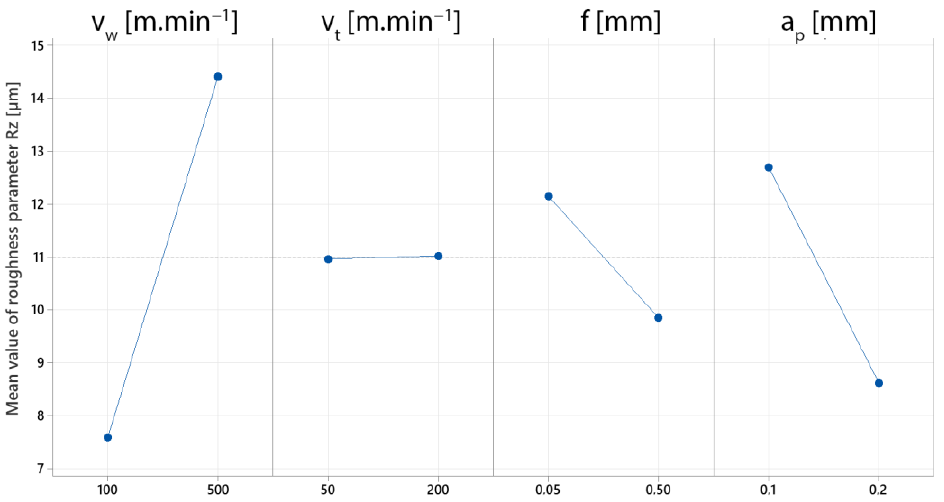
Figure 11. Main effects plot of the roughness parameter Rz.